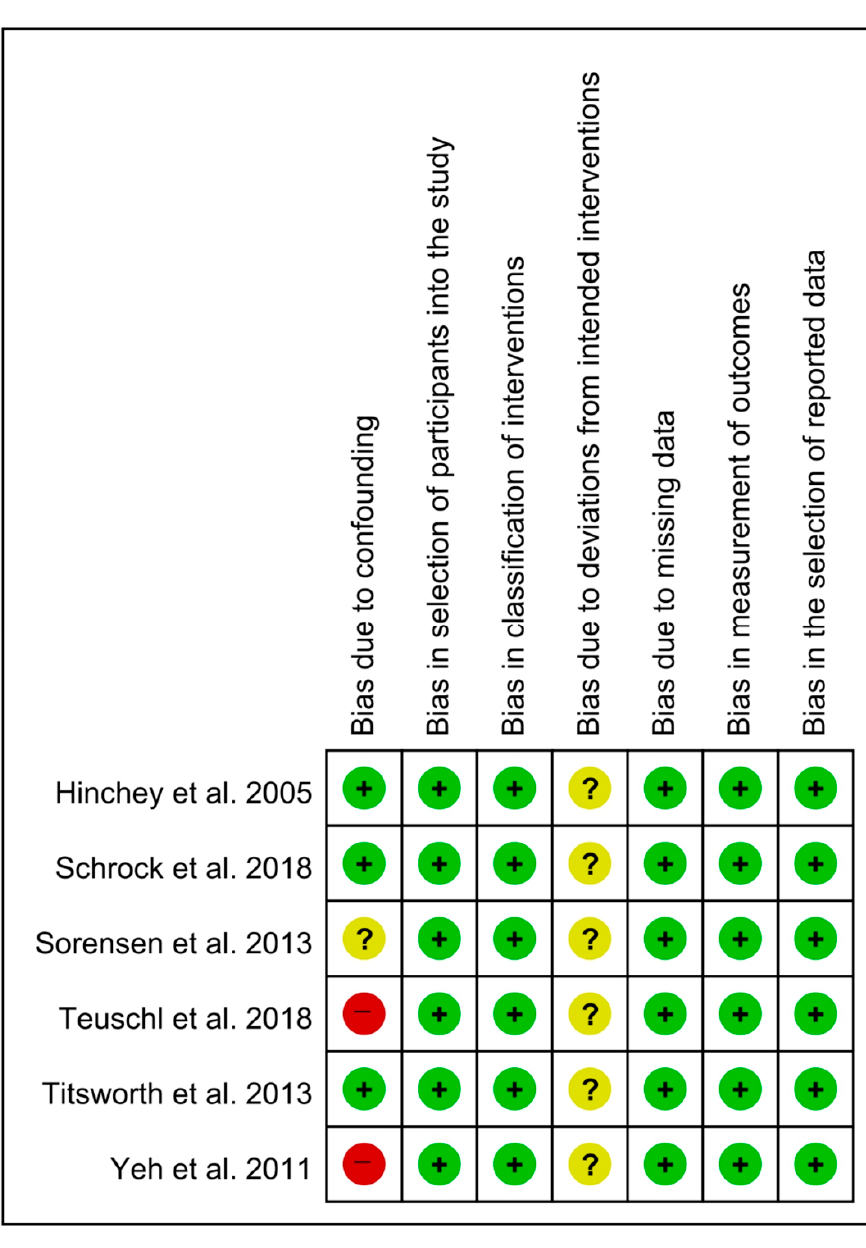
Figure 2. Results of quality assessment of the selected studies, [6–11].